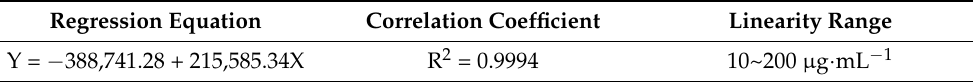
Table 2. The relationship between the fucoxanthin concentration and the peak area. Regression Equation Correlation Coefficient Linearity Range Y = − 388,741.28 +